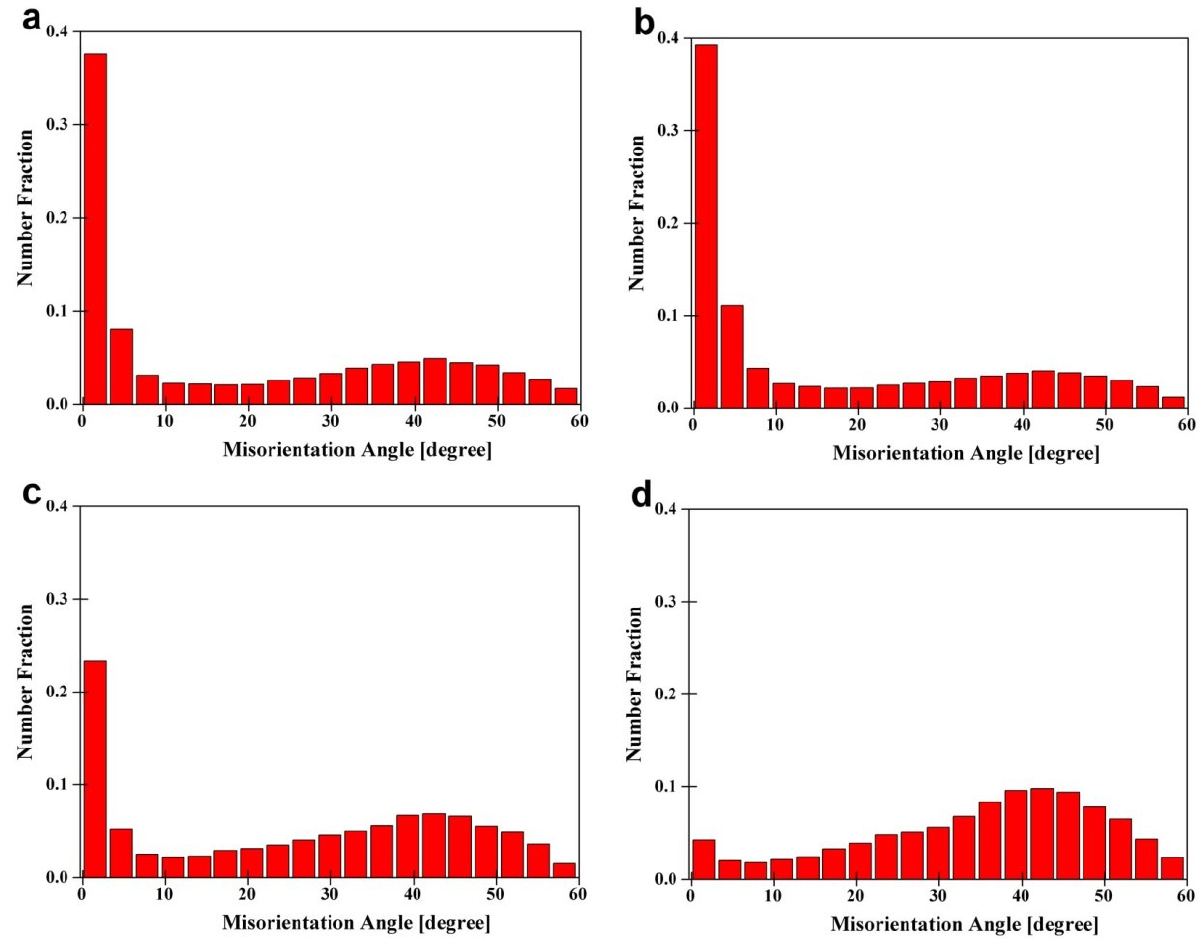
Figure 11: Misorientation angle distribution for (a) S1-hot rolled, (b) S2-hot rolled, (c) S1-normalized, and (d)